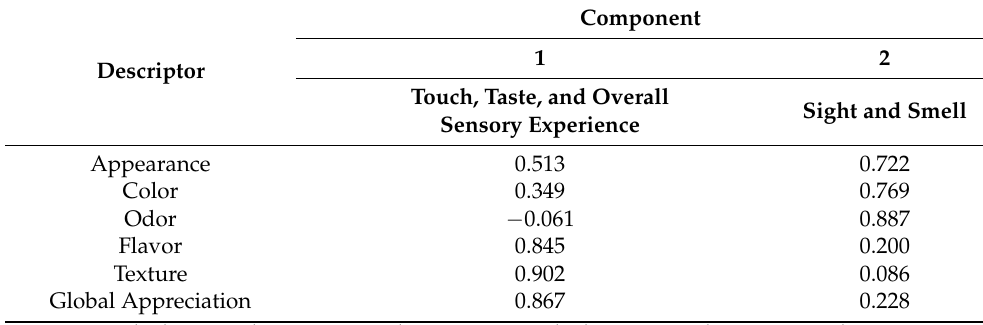
Table 6. Rotated component matrix for each dehydrated piper gurnard descriptor.